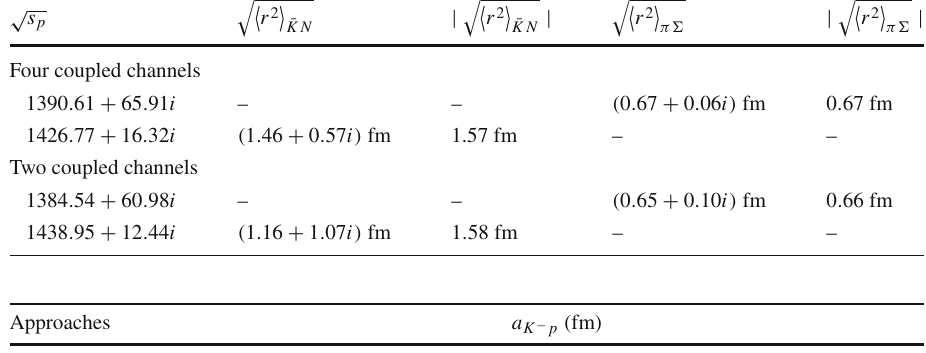
Table 5 Scattering length of K − p channel